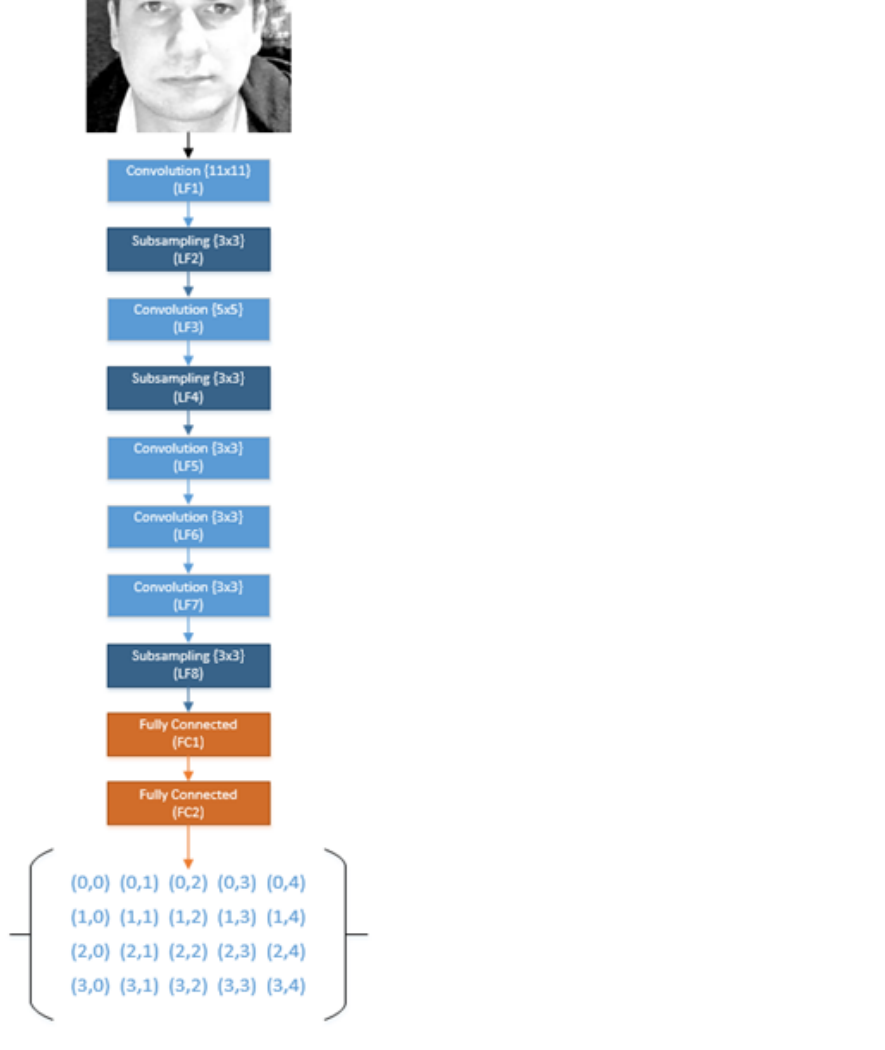
Figure 6. Network architecture for the network processing face images